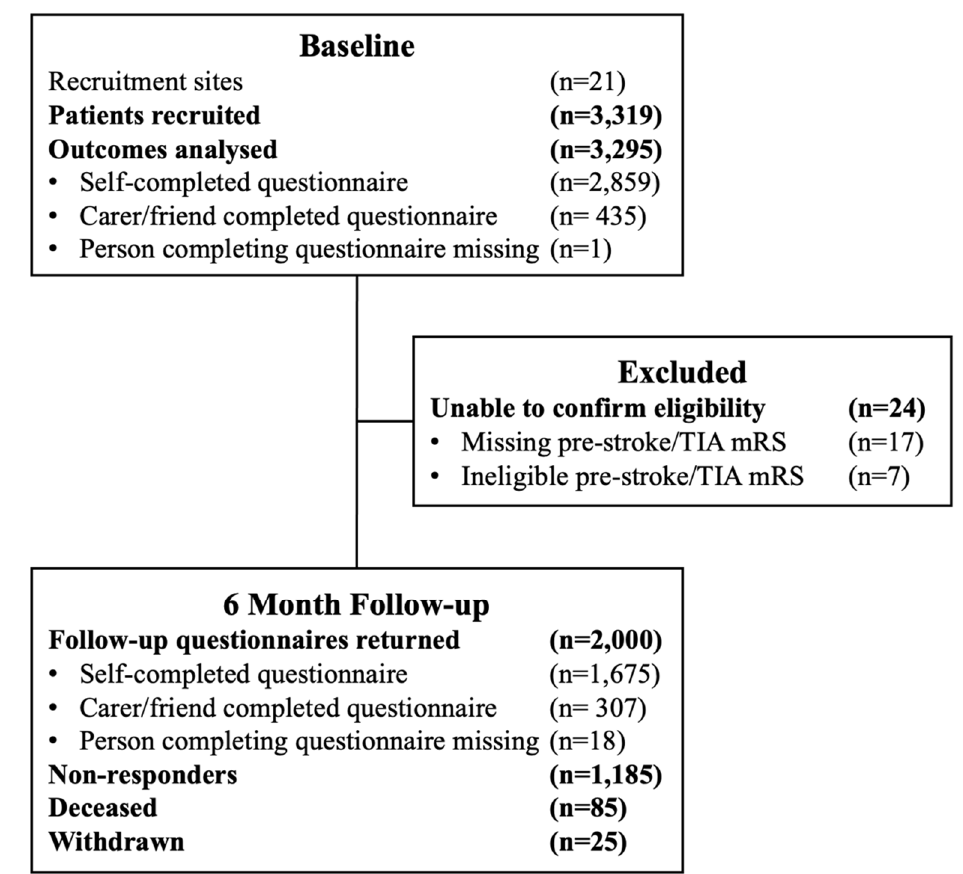
Figure 1. Participant recruitment and exclusion.